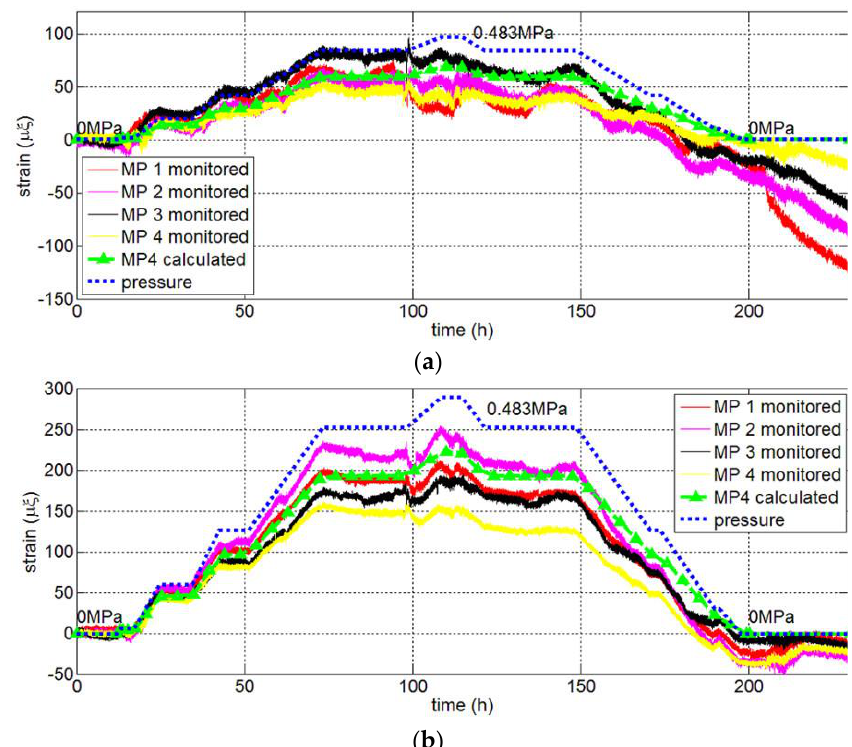
Figure 13. The comparison between monitoring results and calculation results. ( a ) Vertical direction; ( b ) Circumferential direction. Appl. Sci. 2017 , 7 , 419